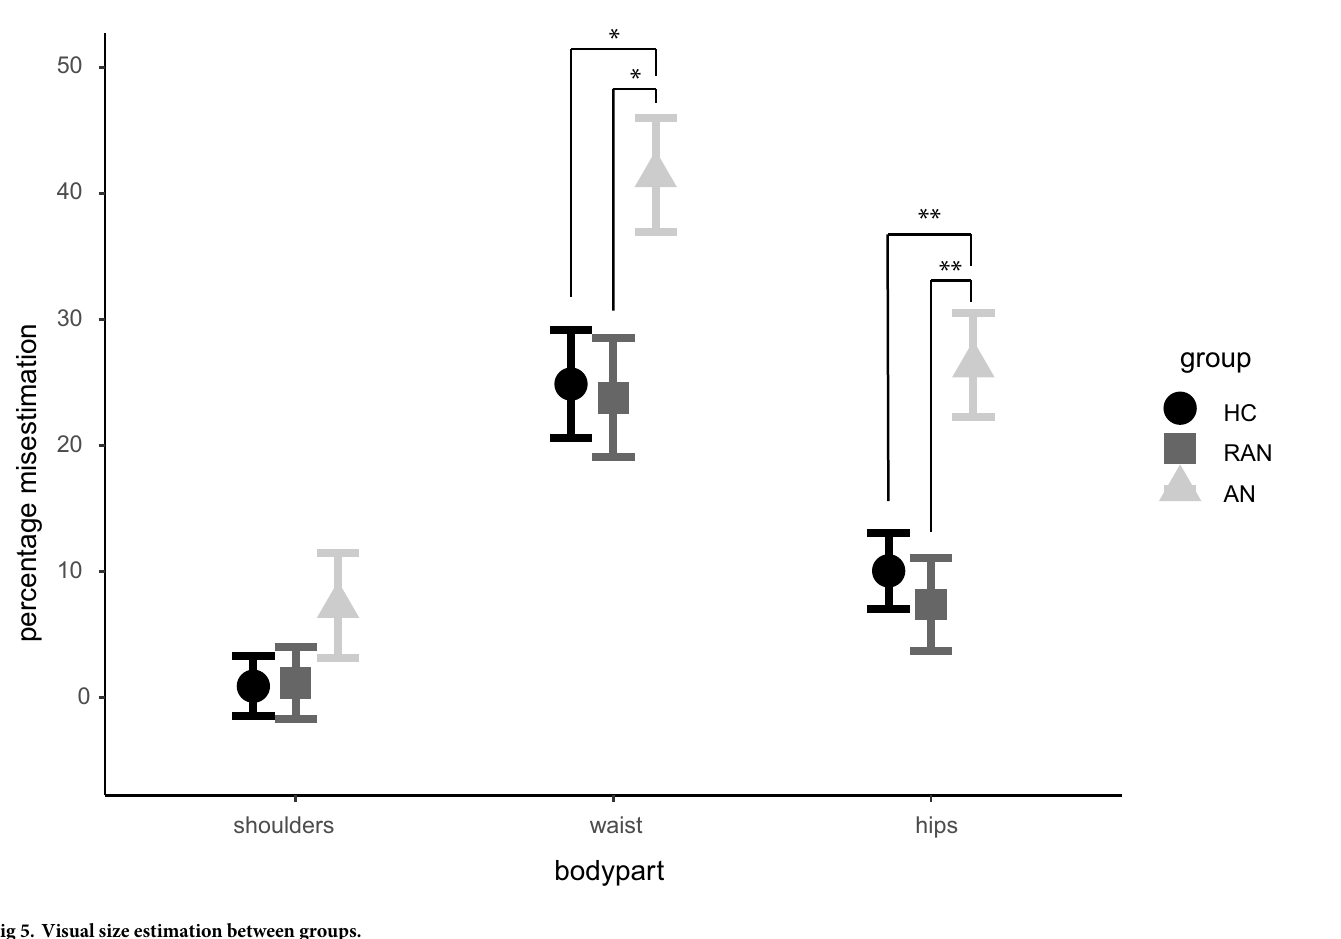
Fig 5. Visual size estimation between groups.